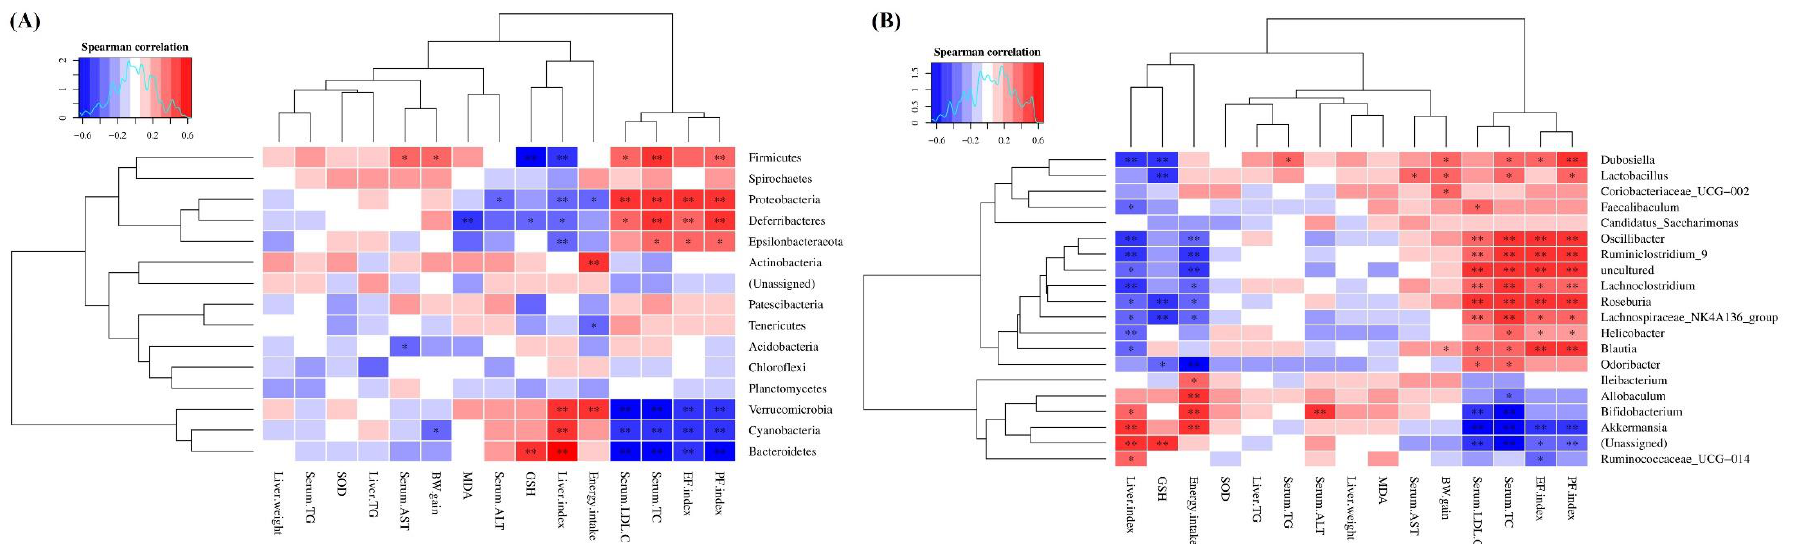
Figure 10. Correlations between the relative abundance of gut microbiota at phylum ( A ) and genus ( B ) levels and NAFLD phenotypes induced by long-term HFD exposure. The NAFLD phenotypes included obesity characteristics, liver damage parameters and liver oxidative injuriers. Asterisk (*) indicates that the correlation between NAFLD phenotypes and the relative abundances of gut microbiota was statistically significant (* FDR < 0.05, ** FDR < 0.01). BW, body weight; EF index, the ratio of epididymal fat mass to body weight; PF index, the ratio of perirenal fat mass to body weight.